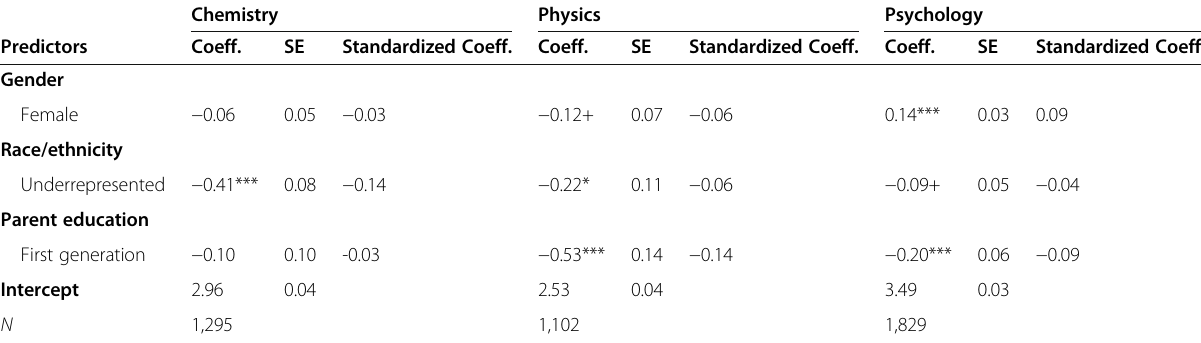
Table 5 Multiple regression results for demographic characteristics predicting course grade in introductory chemistry, physics, and psychology